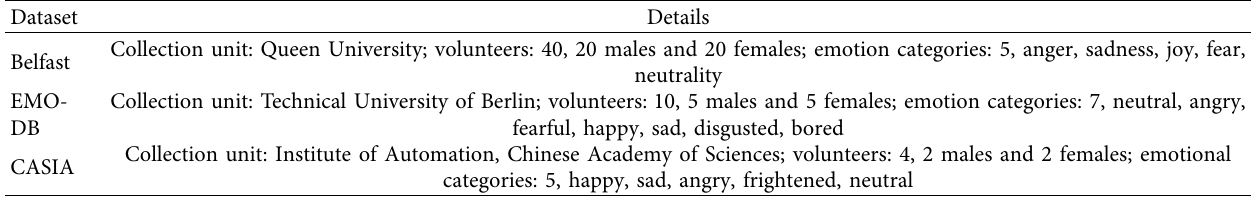
Table 4: Dataset introduction.